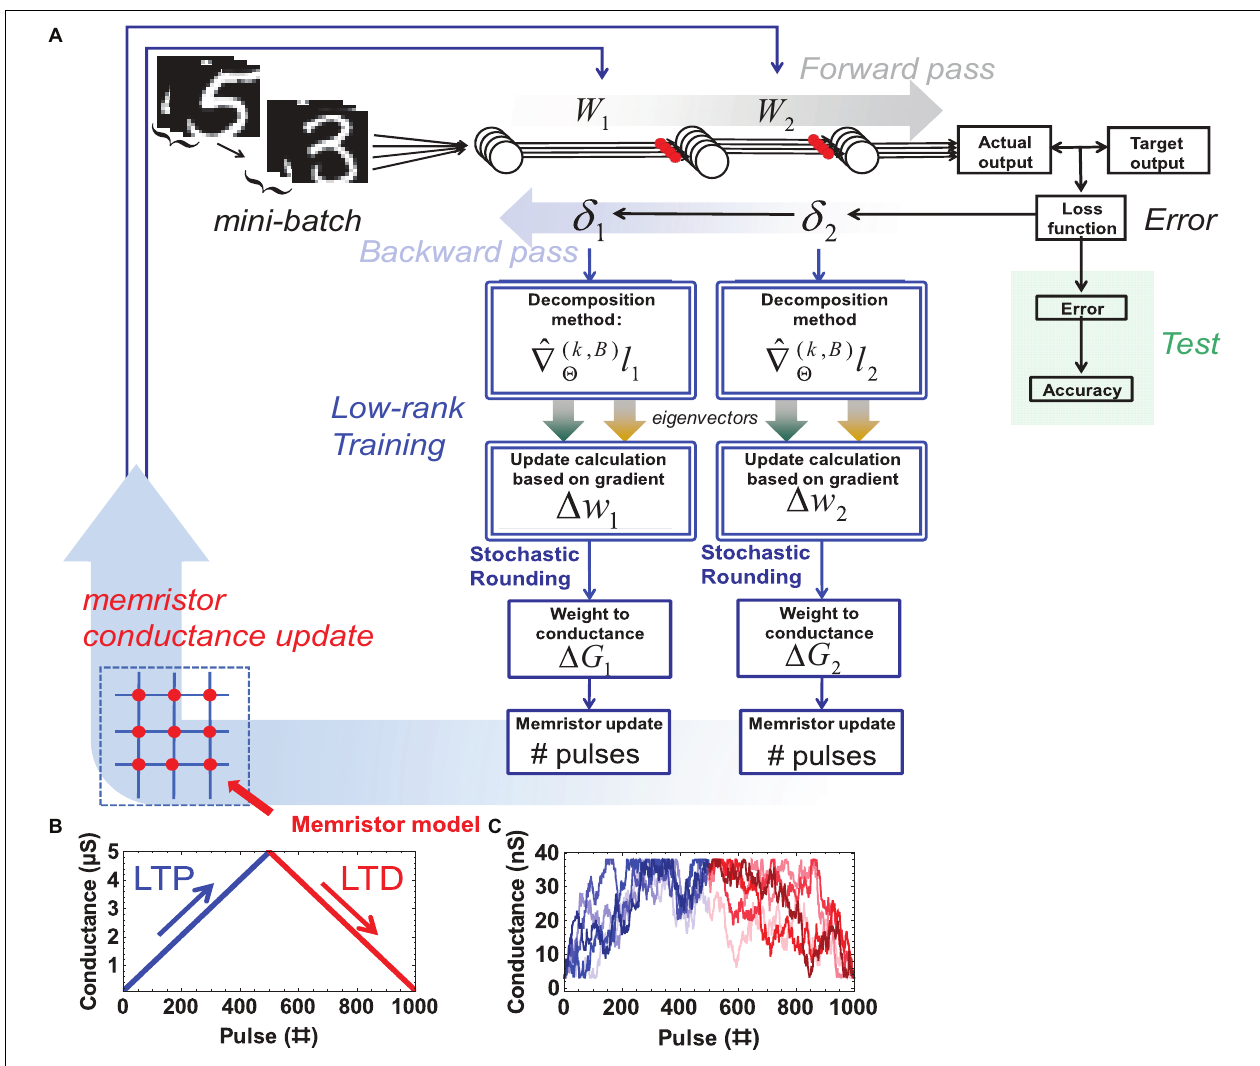
FIGURE 4 | The code structure and device models (A) expanded NeuroSim v3.0 with added modules and functions highlighted with a double border. (B) Ideal memristor with linear symmetric and reproducible weight update and a large ON / OFF ratio vs. (C) Non-ideal memristor model with smaller ON / OFF ratio, weight update nonlinearity, and variability (5 cycles